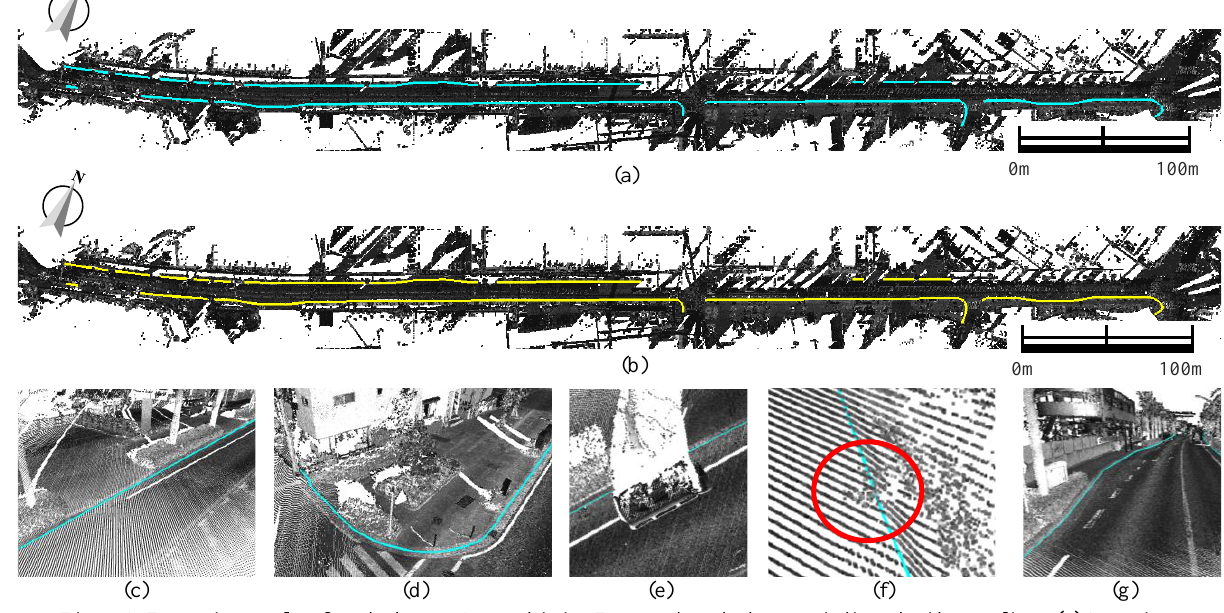
Figure 9. Extraction results of road edges at Kawasaki city. Extracted road edges are indicated with cyan lines. (a) Overview of the extracted road edges by the proposed method. (b) Manually extracted road edges for evaluation. (c) Curb cut section. (d) Intersection. (e) Curb occlusion part by vehicle. (f) Curb occlusion part by weeds. (g) Bus bay where road edges are not parallel to the MLS driving